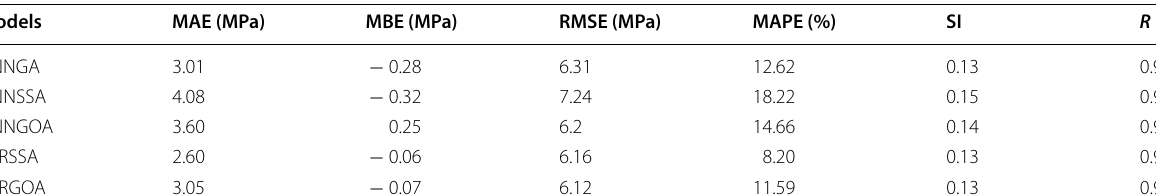
Table 2 Models’ statistic indicators.